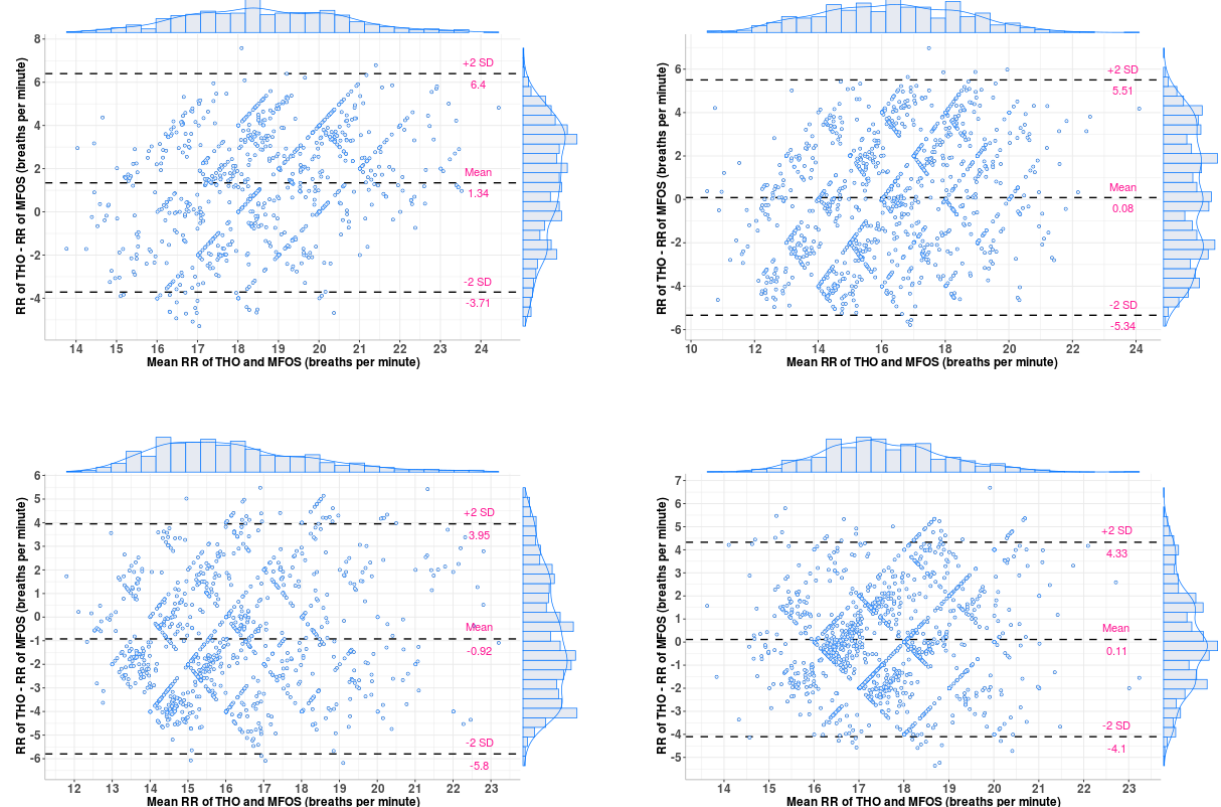
Figure 11. Bland-Altman plots of the respiratory rates for patients 3, 4, 5, and 9 (ie, top left, top right, bottom left, and bottom right, respectively). ECG: electrocardiogram; HR: heart rate; MFOS: microbend fiber optic sensor; RR: respiratory rate; THO: thoracic